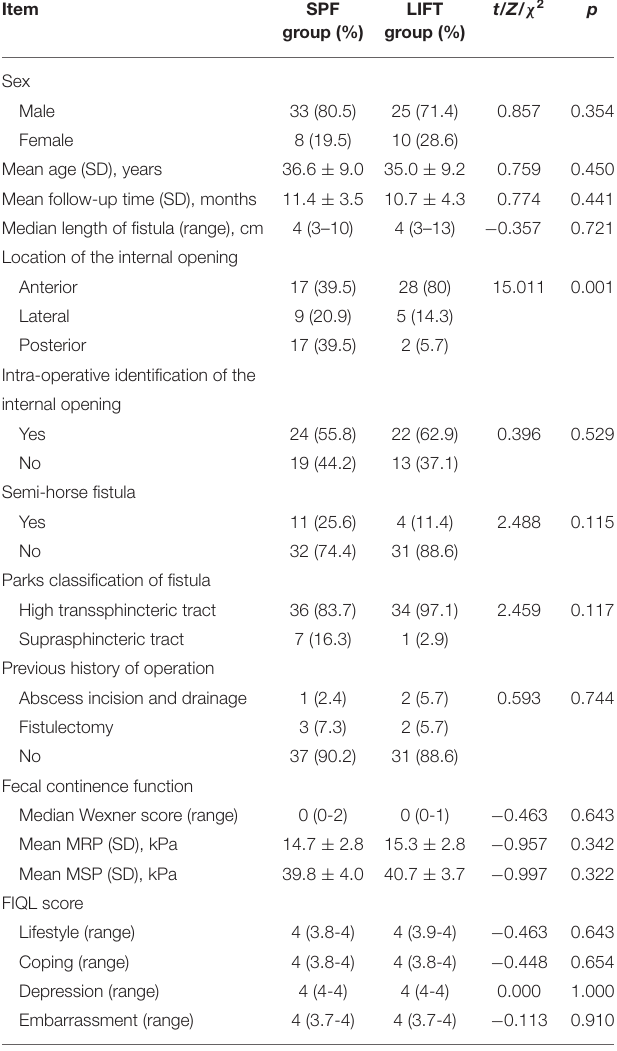
TABLE 1 | Baseline characteristics of